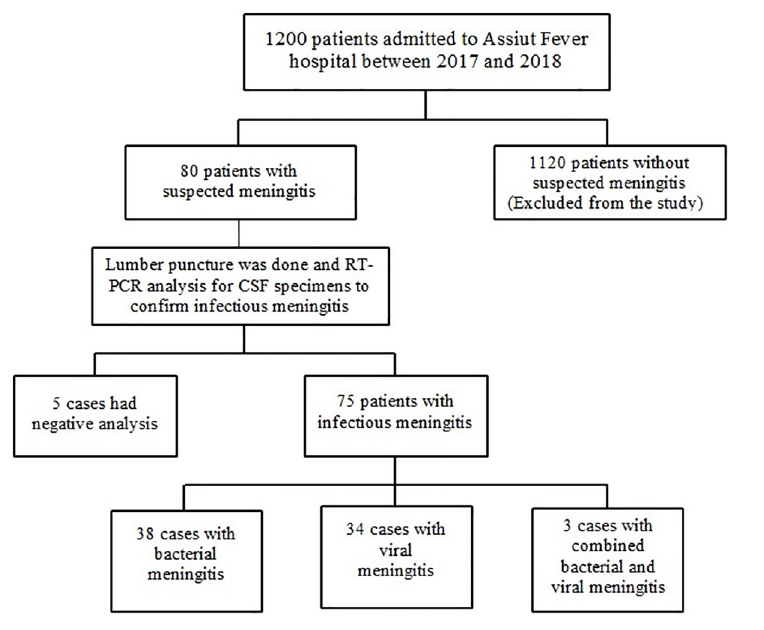
Fig 1. The patient flow chart in the